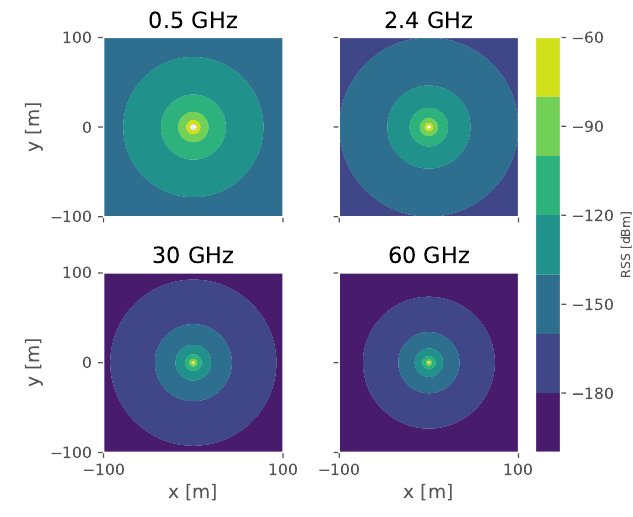
Figure 2. Ideal radio signal propagation at 0.5, 2.4, 30 and 60